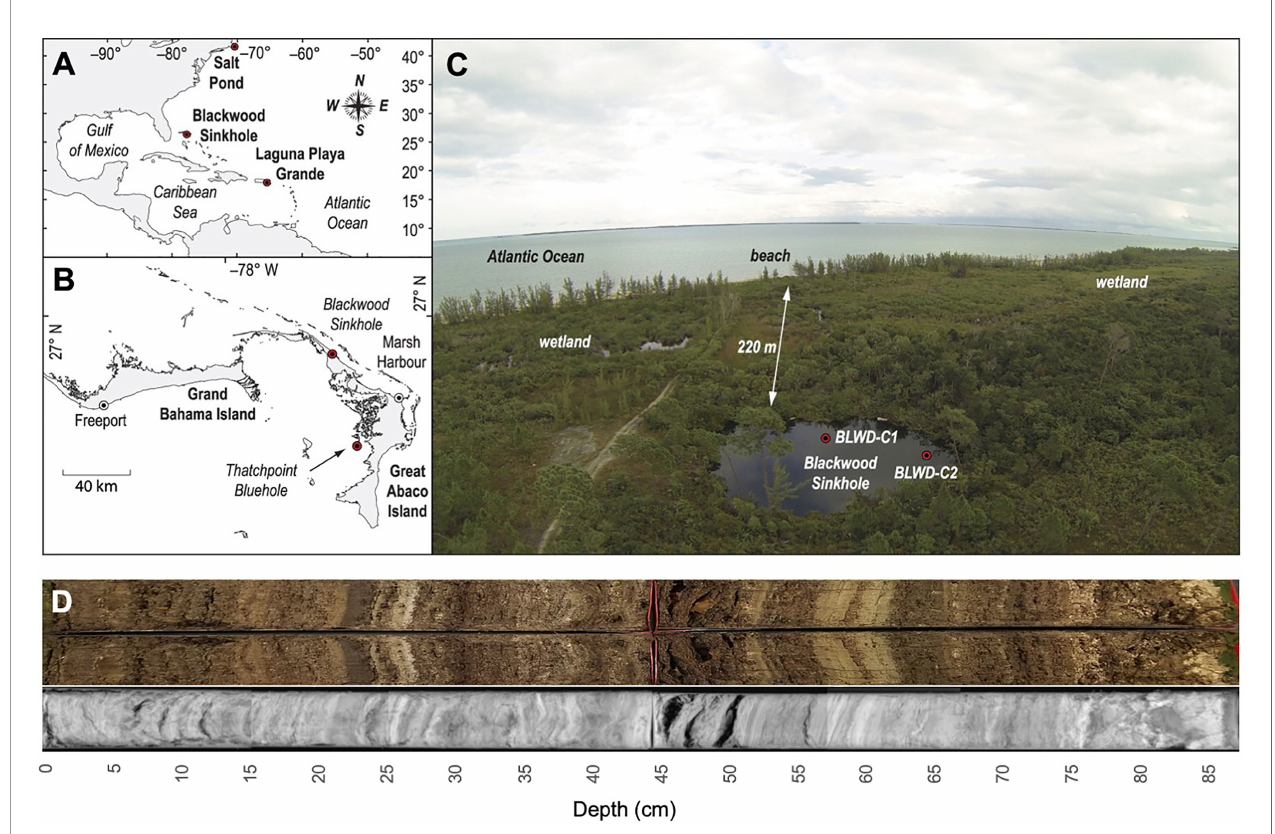
FIGURE 1 | Map of Blackwood Sinkhole within the context of the Bahamas region. (A) The western North Atlantic region noting the location of the Blackwood Sinkhole on the Little Bahama Bank. (B) Islands on the Little Bahama Bank, and the position of Blackwood Sinkhole on Great Abaco Island. (C) Aerial photograph of Blackwood Sinkhole and the relation (220 m) to the Atlantic Ocean. Red dots indicate coring locations, including BLWD-C7, used in this study. Indicating the location of the core sampled in this study, BLWD-C7. (D) Radiograph and picture of core BLWD-C7. Figure adapted from (Tamalavage et al.,